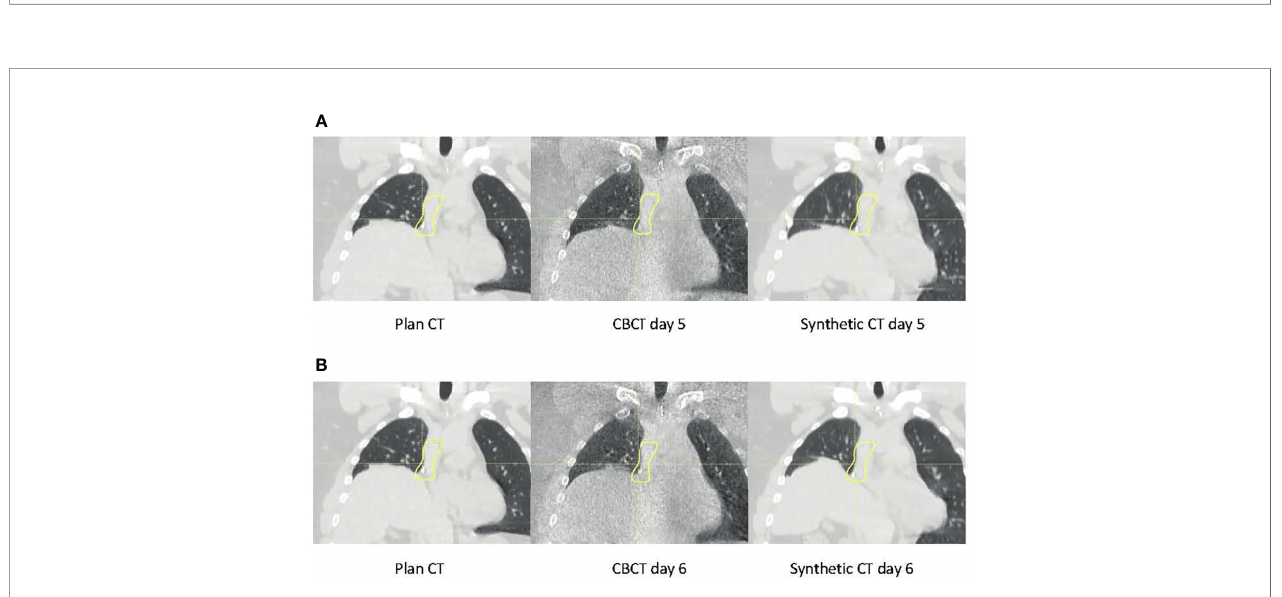
FIGURE 11 | Planning CT (left), daily cone-beam CT (CBCT (middle), and synthetic CT (right) for the same patient on (A) day 5 and (B) day